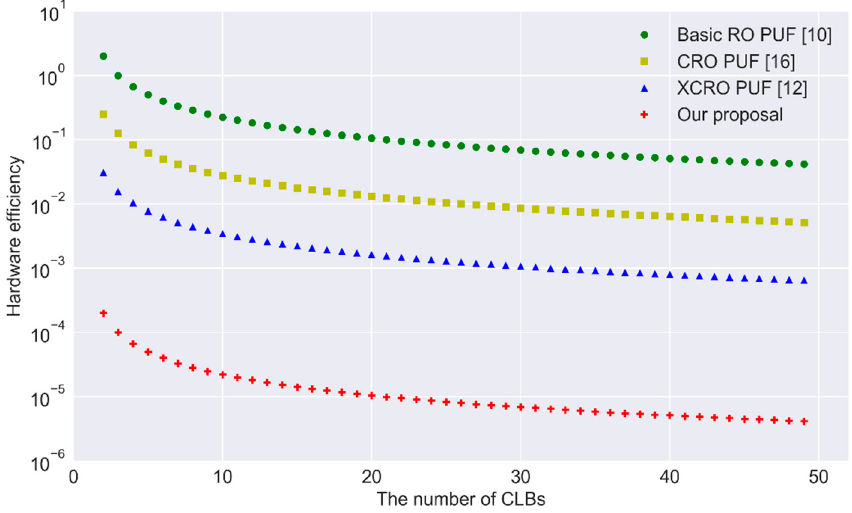
Figure 10. Hardware efficiency of different types of RO PUFs.